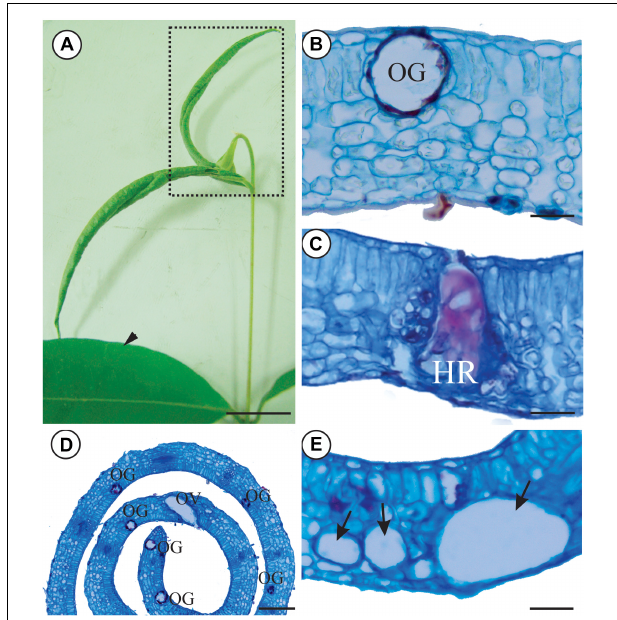
FIGURE 1 | Non-galled leaves and galls induced on leaves of Myrcia splendens by an undescribed species of Nexothrips (suborder Terebrantia) (A) Non-galled leaves and stem branch with leaf rolling galls. (B) Anatomy of non-galled leaves, evidencing the mesophyll and oil glands. (C) Gall mesophyll, evidencing the hypersensitive reaction in response to the inducer’s feeding activity. (D) Anatomy of a gall, evidencing the increased number of secretory cavities. (E) Gall mesophyll, evidencing the reduction of intercellular spaces and air cavities. Arrowhead: Non-galled leaves, Dashed: Rolling gall, OG: Oil gland, OV: Oviposition, HR: Hypersensitive area, Arrow: Air cavities Scale bars: A : 2 cm, B , C , E : 50 µ m; D : 200 µ